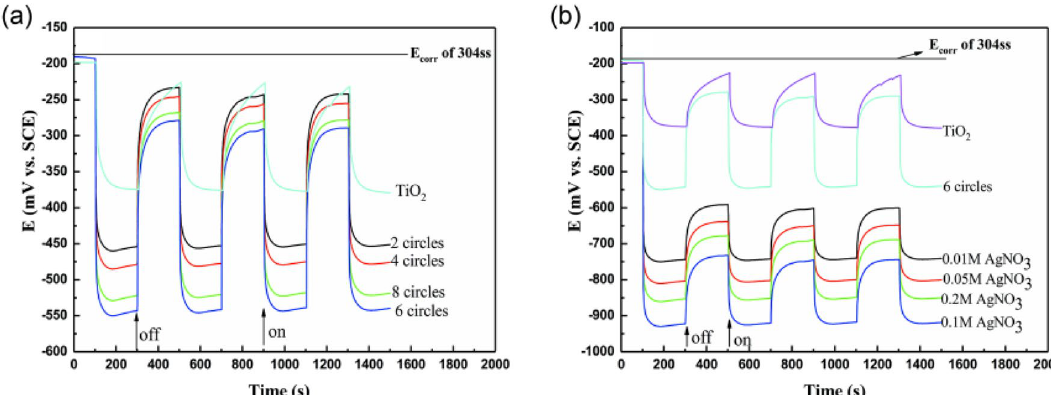
Figure 4. OCP variations of the 304 SS electrode coupled with the NiS/TiO 2 nanocomposite ( a ) and Ag/NiS/ TiO 2 nanocomposite ( b ) with and without illumination (λ > 400